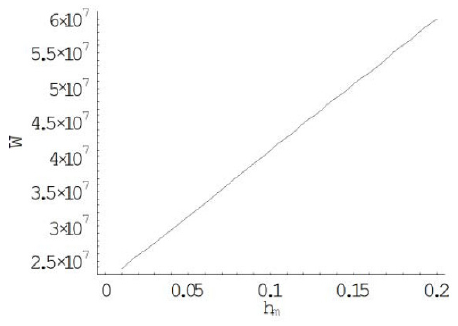
Figure 9. Total cost versus parameter h m .